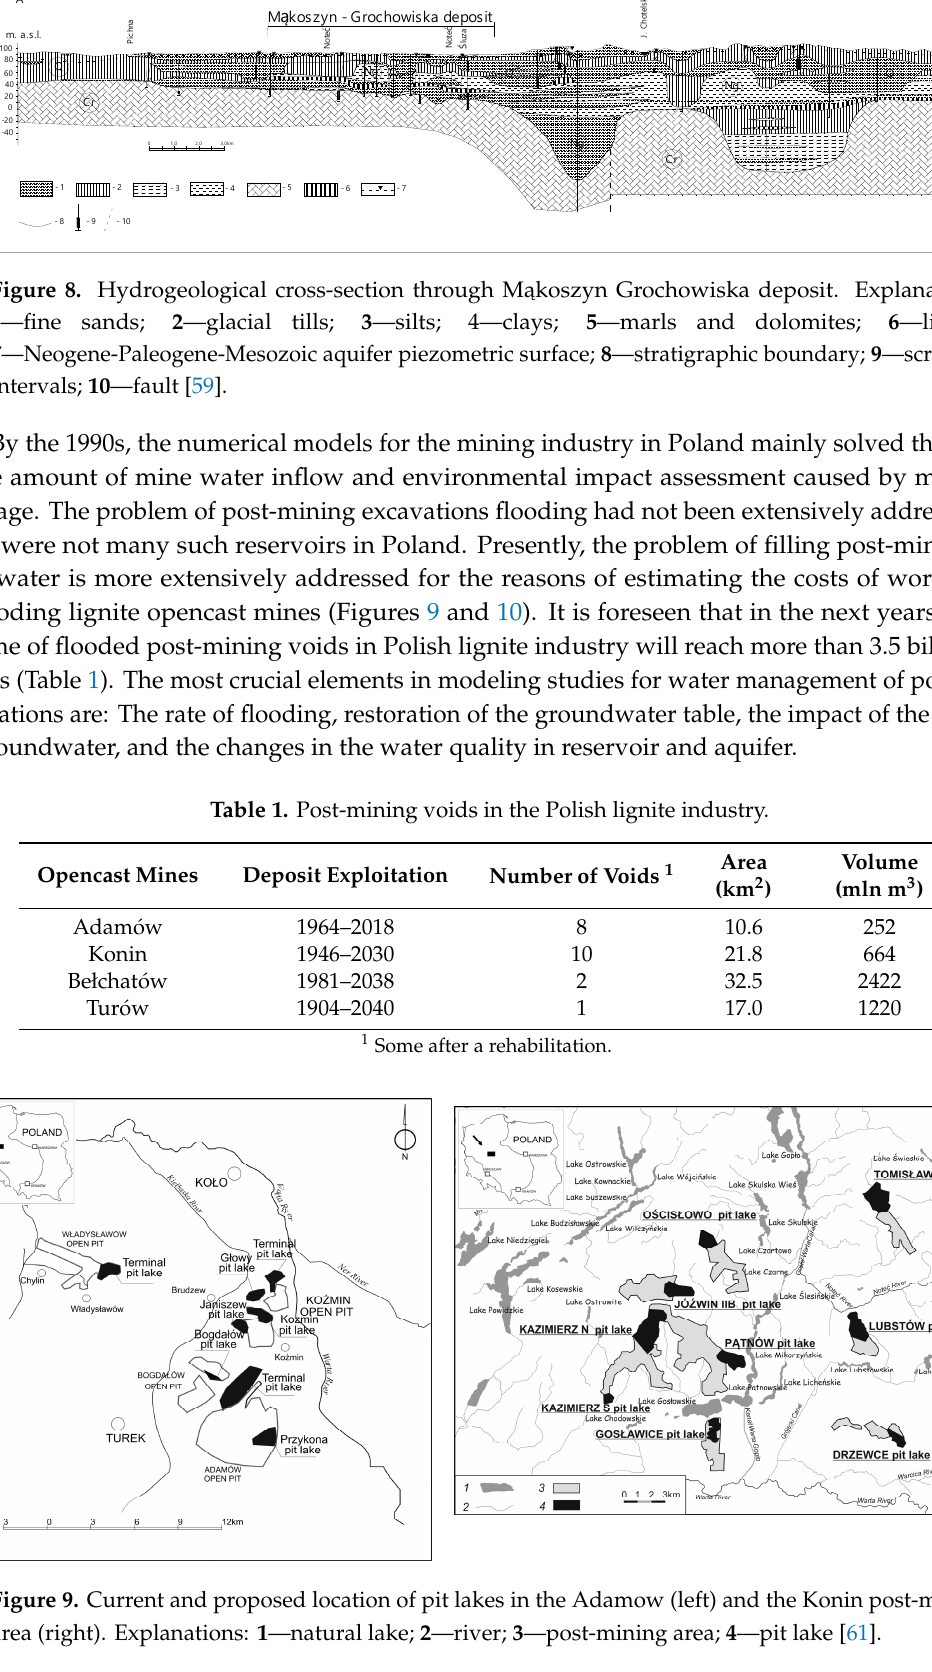
5 —hydrogeological cross section; 6 —mining areas [59].